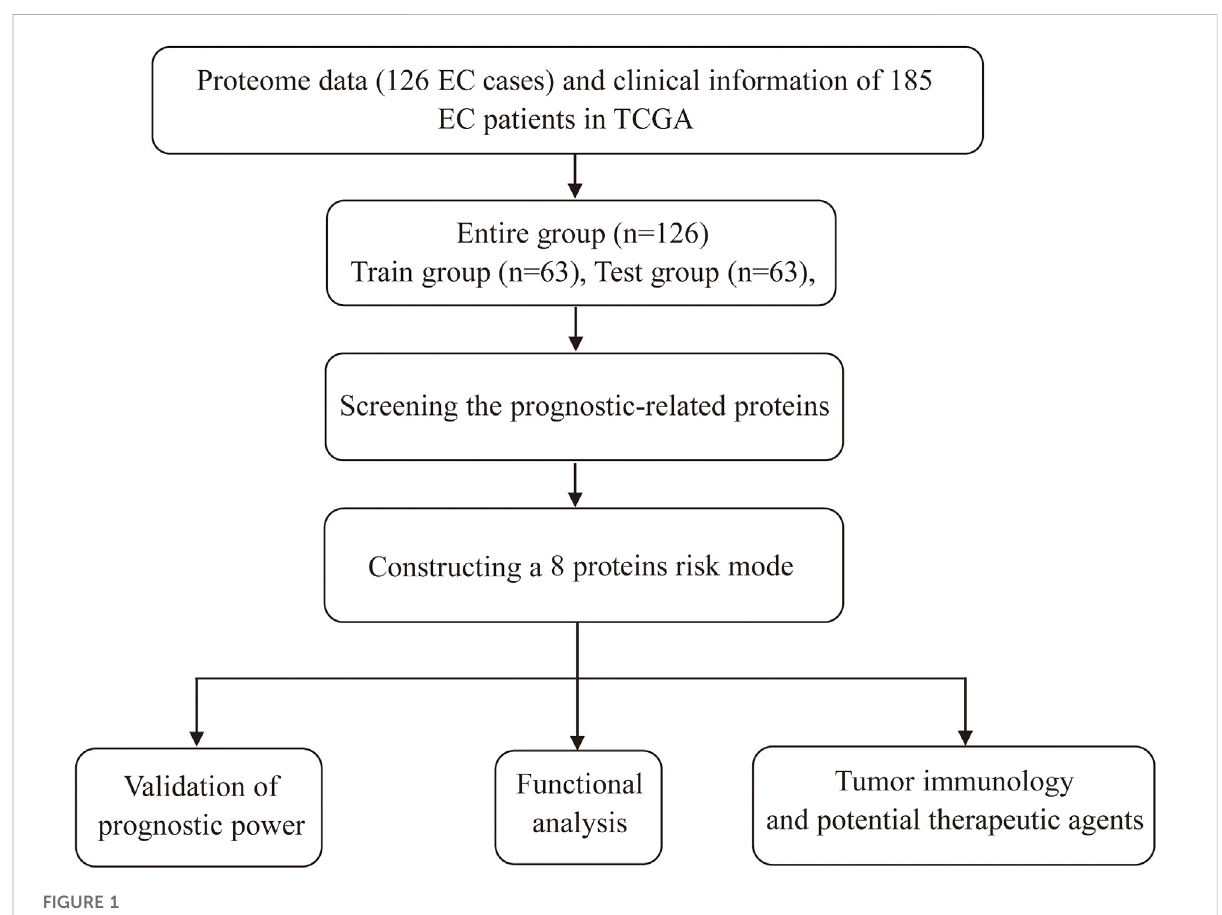
FIGURE 1 Schematic diagram of the research